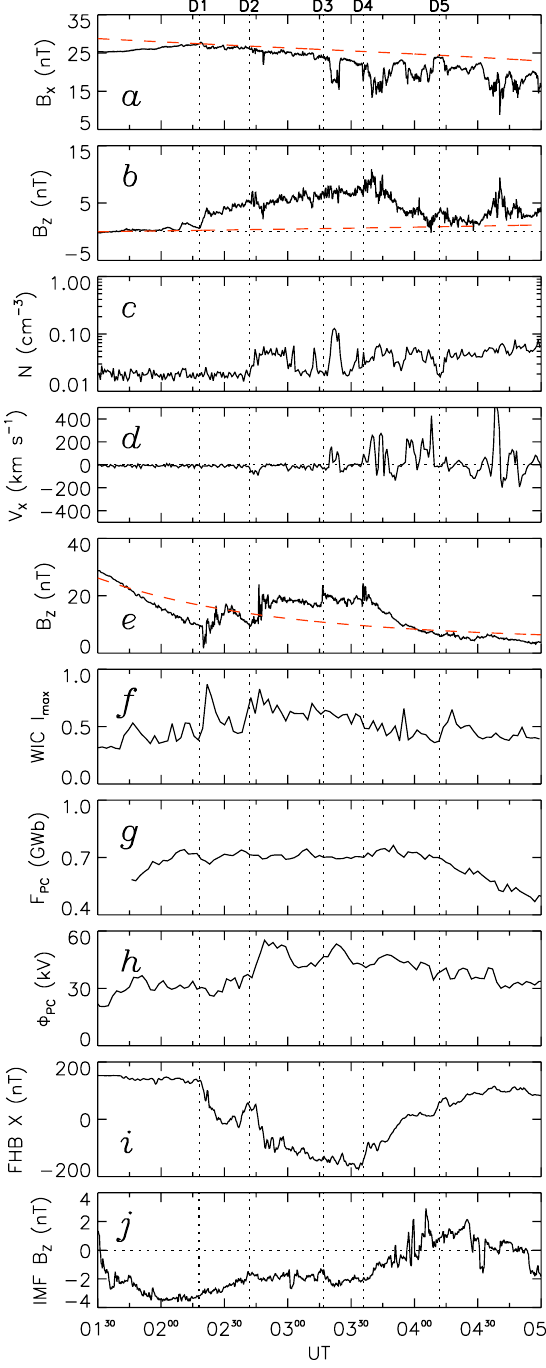
Fig. 10. An amalgam of observations from ground and space. (a) B x and (b) B z from C1. (c) and (d) Ion density and velocity from C1. (e) B z from TC1. (f) and (g) Auroral brightness and polar cap flux from IMAGE FUV/WIC. (h) Cross-polar cap potential from SuperDARN. (i) X-component magnetogram from FHB. (j) IMF B z from ACE, lagged to the